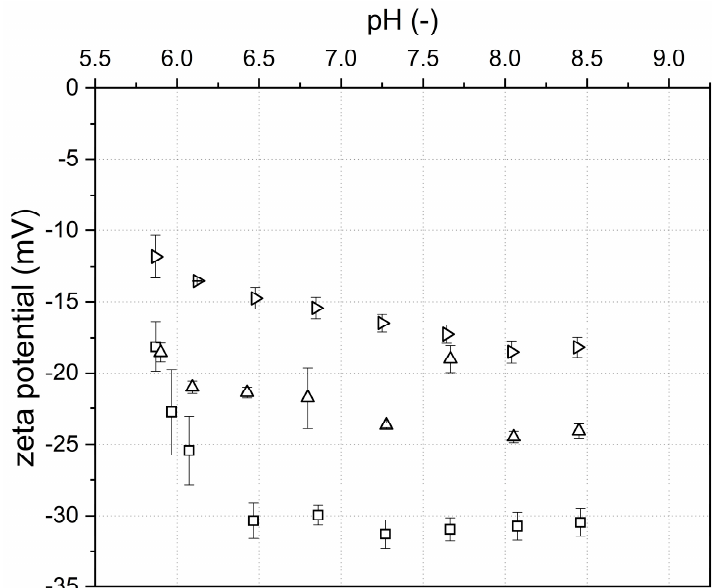
Figure 1. Zeta potential of native β -Lg solutions (c = 10 g L − 1 ) as a function of the pH at varying NaCl concentrations ( □ 0, △ 20, and ▷ 60 mM) before heat treatment. Error bars indicate standard deviation.